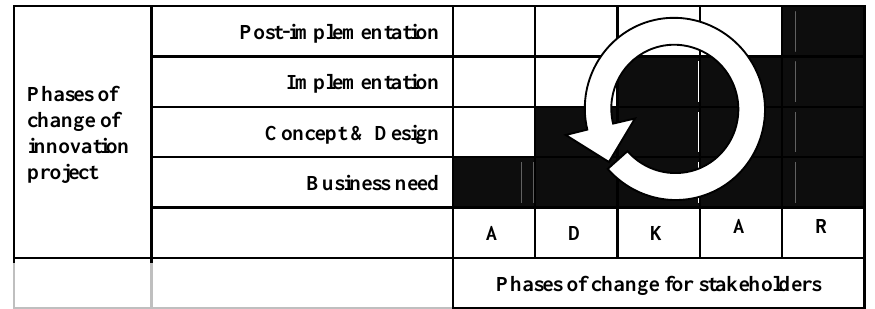
Fig. 8. Continuous innovation program